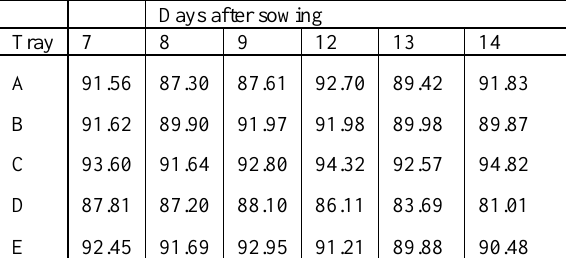
Table 1 . Overall accuracies (in percentage) were obtained by SVM species classification of the hyperspectral images of all sowing trays (A-E) in all days of